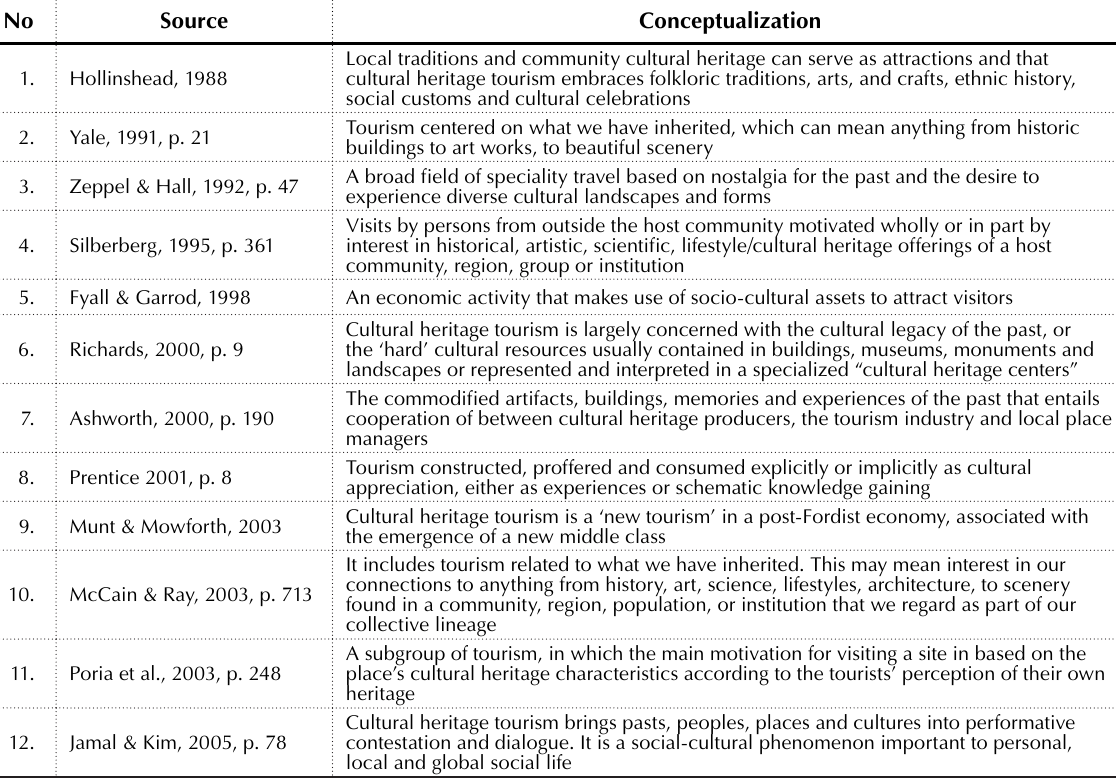
Table 1. Definitions of cultural heritage